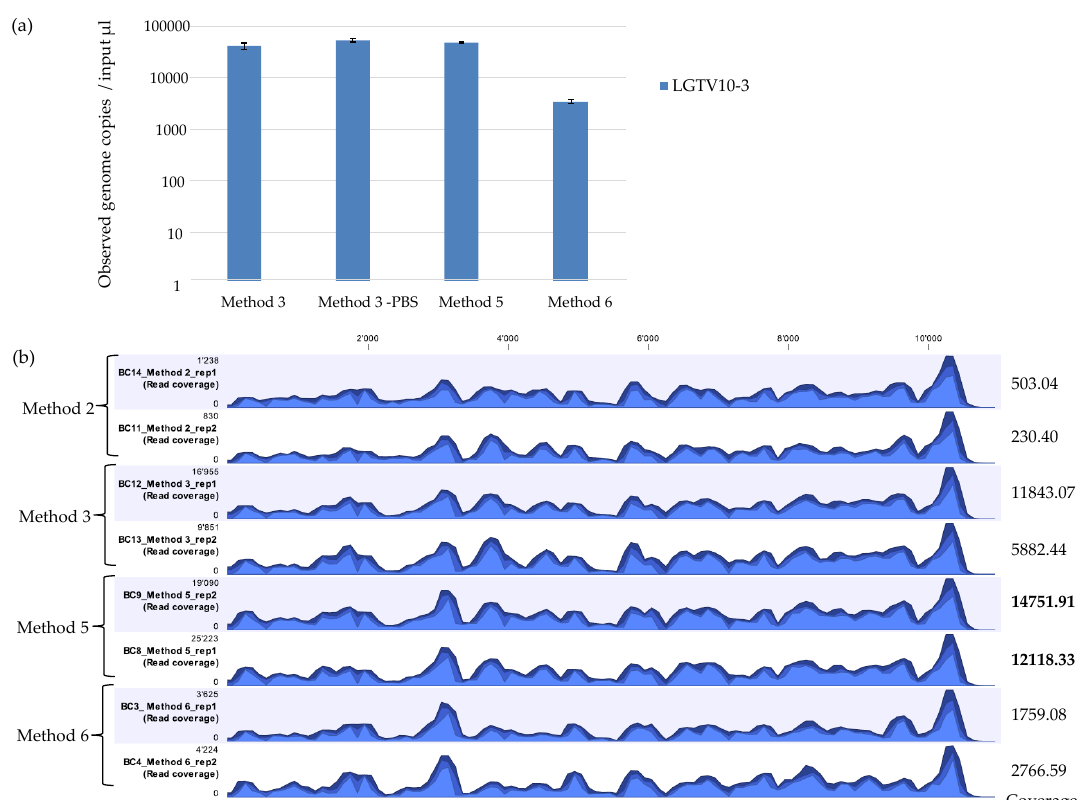
Figure 3. ( a ) Real time qPCR of observed genome copies recovered from further assessment of extraction methods (Method 3, Method 5, and Method 6). Reactions were performed in duplicates on duplicate extractions from LGTV serial dilution at 10 − 3 spiked into tick homogenates. Error bars represent means ± SD. N = 4. ( b ) Coverage track profiles of LGTV mapped reads to the reference genome (TP21 EU790644) recovered using Method 2, 3, 5, and 6. Average coverage values are indicated for each sample on the right. In the graph track, the three blue shades show the minimum (light blue), mean (medium blue), and maximum (dark blue) observed values in a given